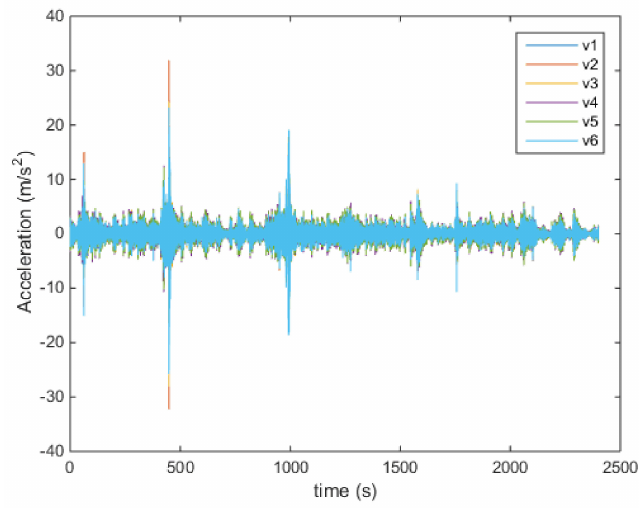
Figure 6. The typical time-history response. Table 2. Comparison of measured and calculated data of truss model (Unit: Hz).